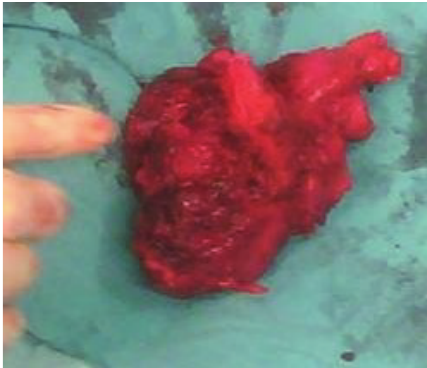
Figure 3: Macroscopic appearance of the